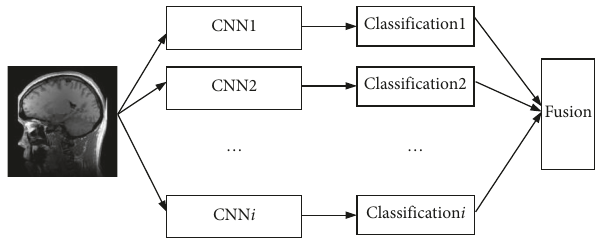
Figure 1: Structure of the multilayer convolutional neural network proposed in this